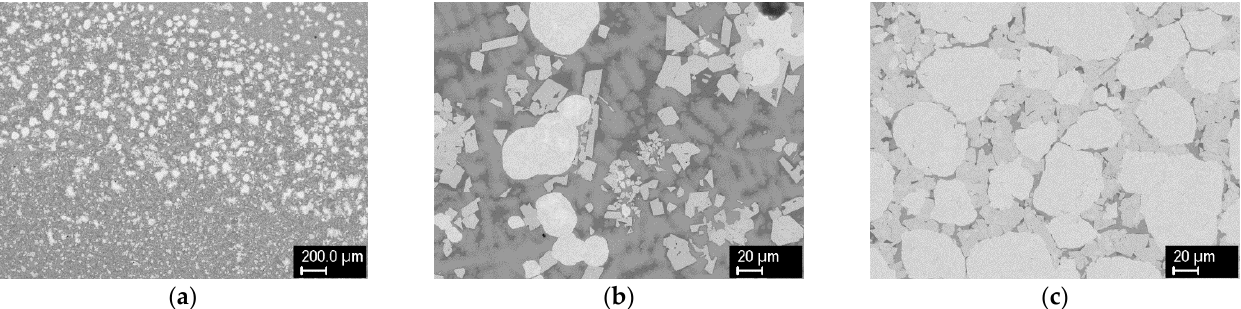
Figure 5. Cross sections of W–Ni cladding made from 50% W mixture on a graphite substrate: ( a ) overview, ( b ) detail from the middle of the cladding, ( c ) detail of a W-rich region.